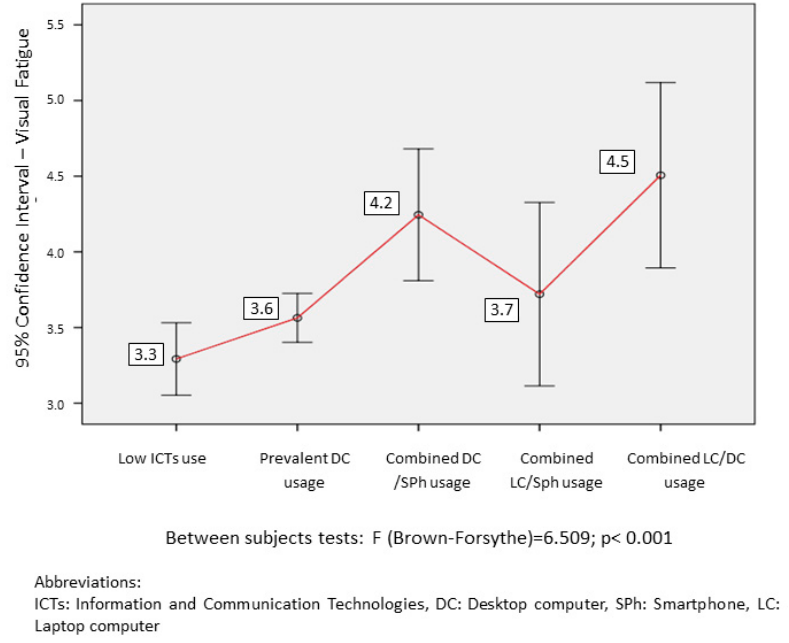
Figure 2. Relationships between visual discomfort and ICT usage pattern.